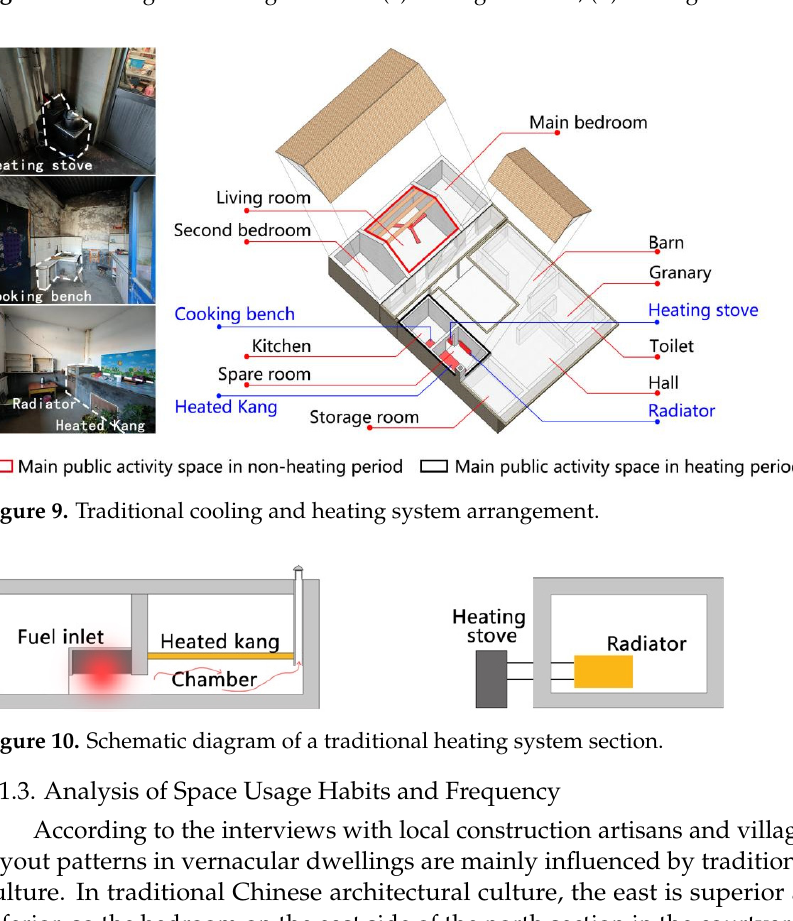
Figure 8. Heating and cooling methods: ( a ) cooling methods; ( b ) heating methods.